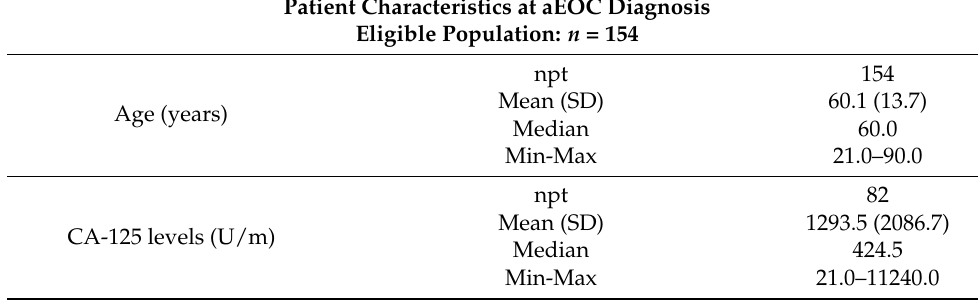
Table 1. Patient